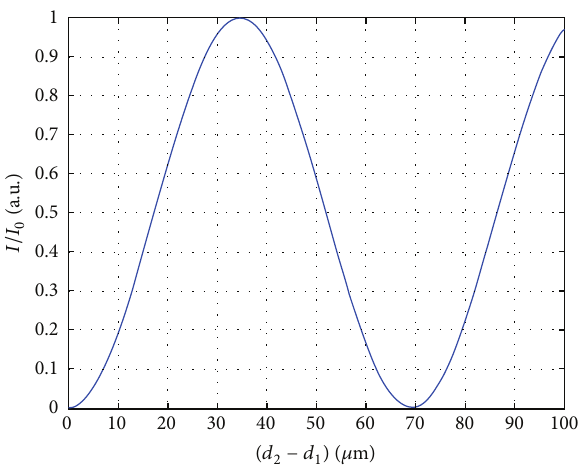
Figure 3: The dependence of the relative intensity of the difference between the thicknesses (𝑑 2 − 𝑑 1 ) of the quartz plates for helium- neon laser